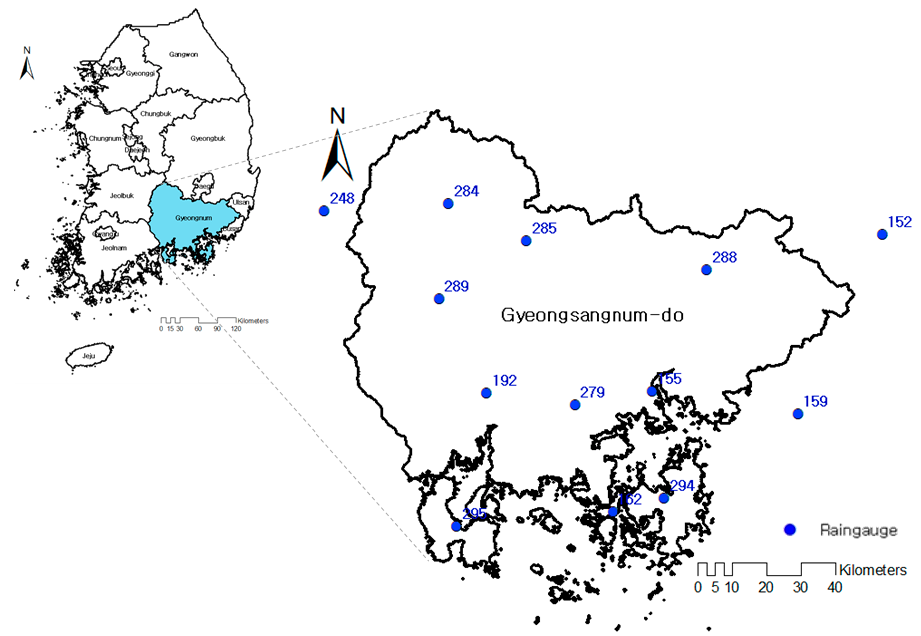
Figure 3. Map of Gyeongsangnamdo, South Korea.